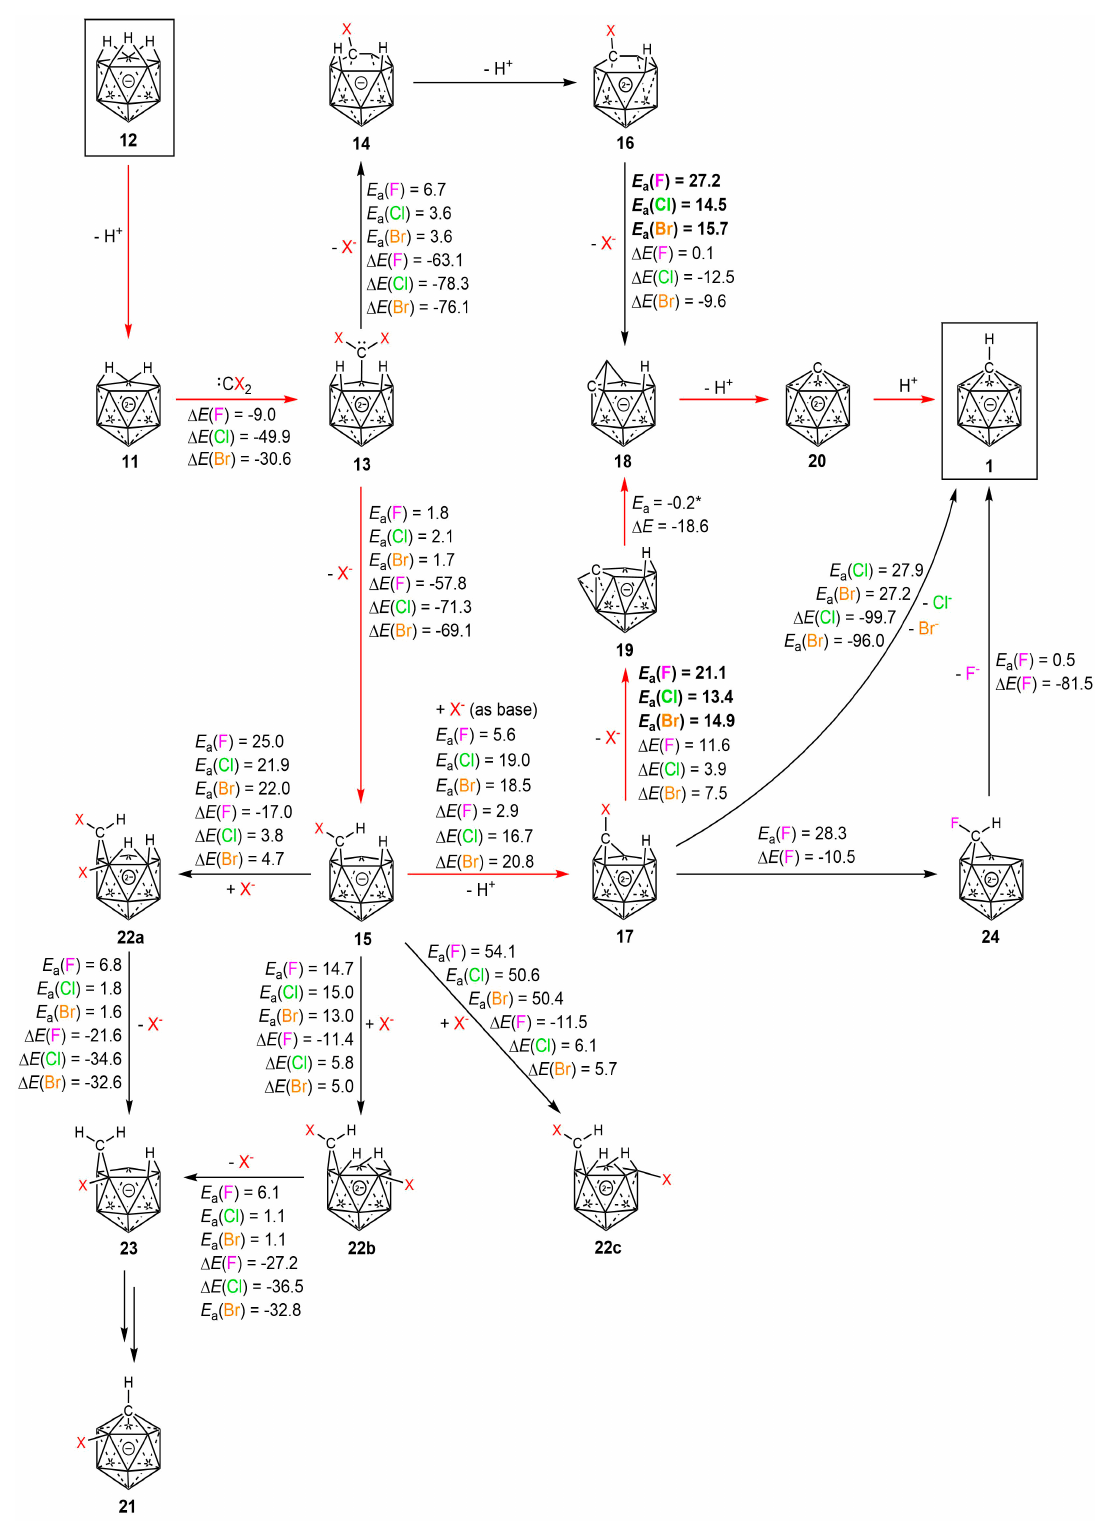
Figure 1. Calculated reaction energies and barriers for conversion of 12 to 1 . Bold: highest barrier in a branch. Red arrows: minimum energy path. Bottom left: pathways for halogenation in position 2. The -H + sign: deprotonation by an added base (e.g. NaH or NaOEt). Asterisk at E a (coversion of 19 to 18 ): without zero-point vibrational energy, 0.01 kcal /